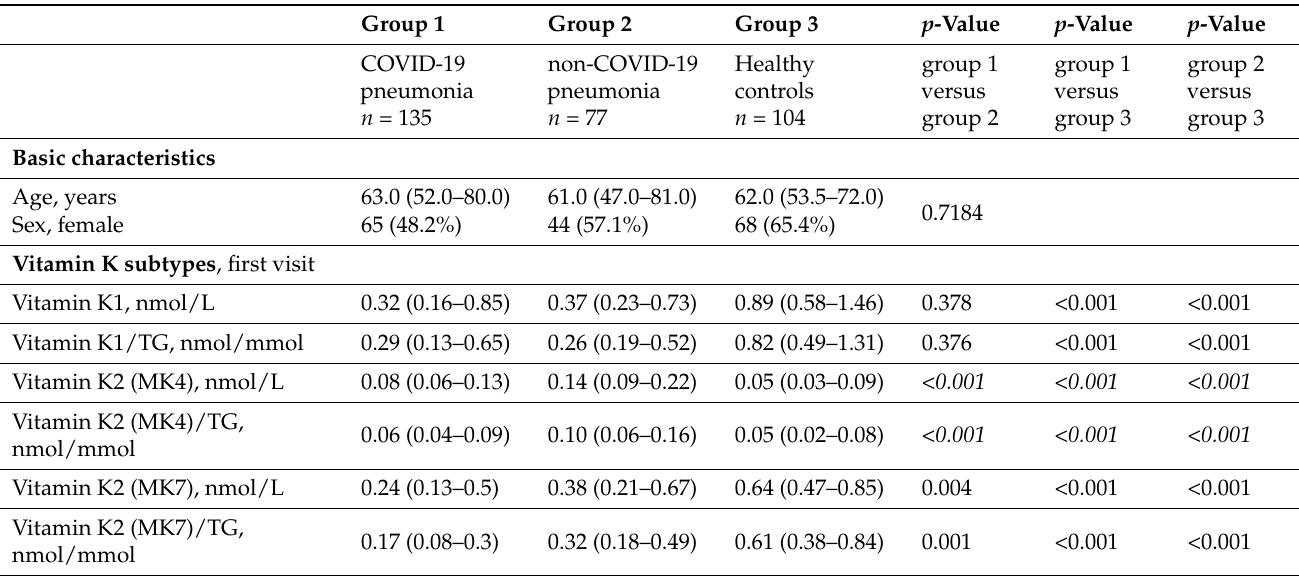
Table 2. Anthropometric and biochemical characteristics of the study